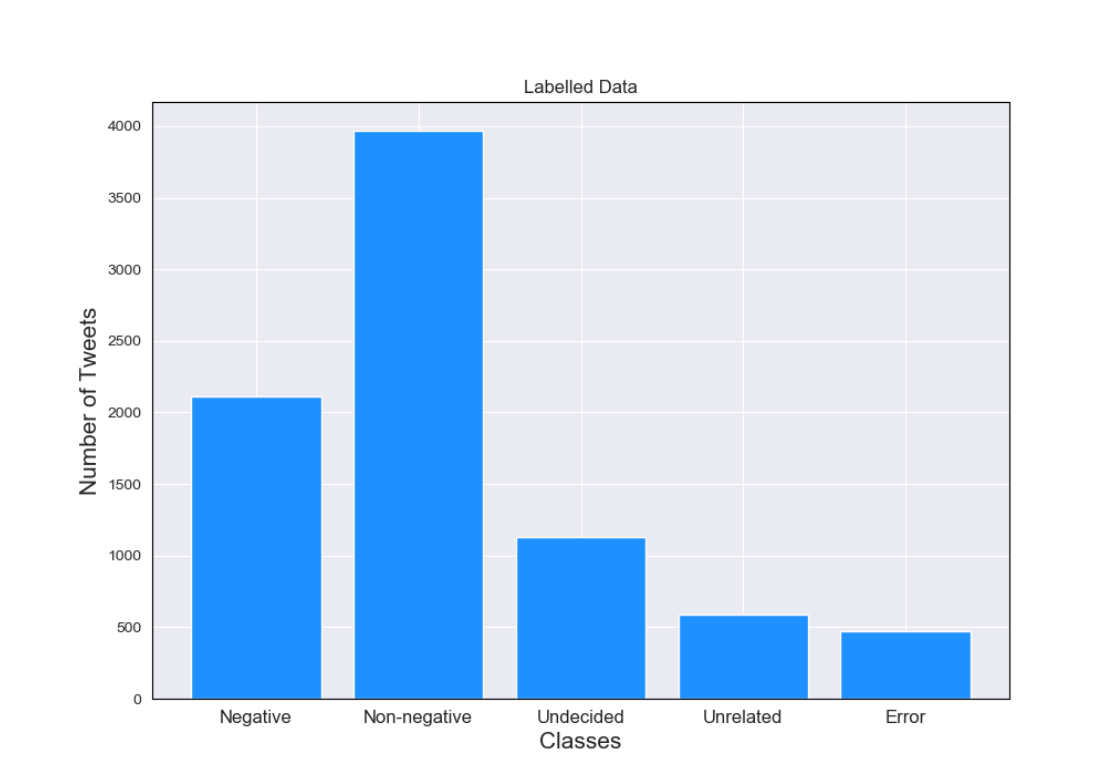
Figure 1. Breakdown of the labeled dataset by